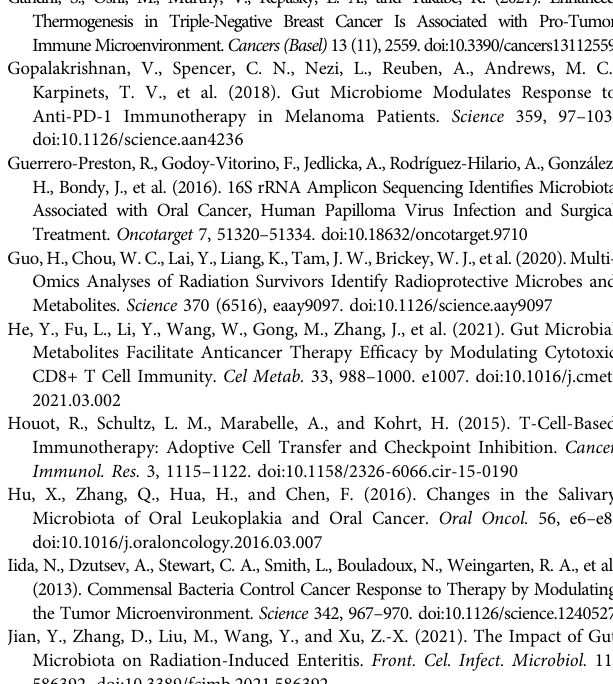
Supplementary Figure S1 | Precancerous lesions and OPCs in mice treated with 4NQO. Healthy BALB/c male mice were housed in SPF environment in Henan University on a 12 h light-dark cycle with food and water available ad libitum. The mice were randomly divided into experimental group ( n = 20) provided with drinking watercontaining100 mg/L 4NQO (sigma, United States) andinto controlgroup ( n = 20) provided with drinking water without 4NQO. Five mice were randomly killed every 4 weeks continuously for 16 weeks. (A) Experimental process line. (B) Body weight of mice. (C) HE staining of glossopharyngeal tissue at different time points. Data represent mean ± SEM. * p < 0.05, n = 5, compared with control. Supplementary Figure S2 | SCFAs levels in the serum of mice treated with Lactobacillus culture supernatant. Lactobacillus culture supernatant